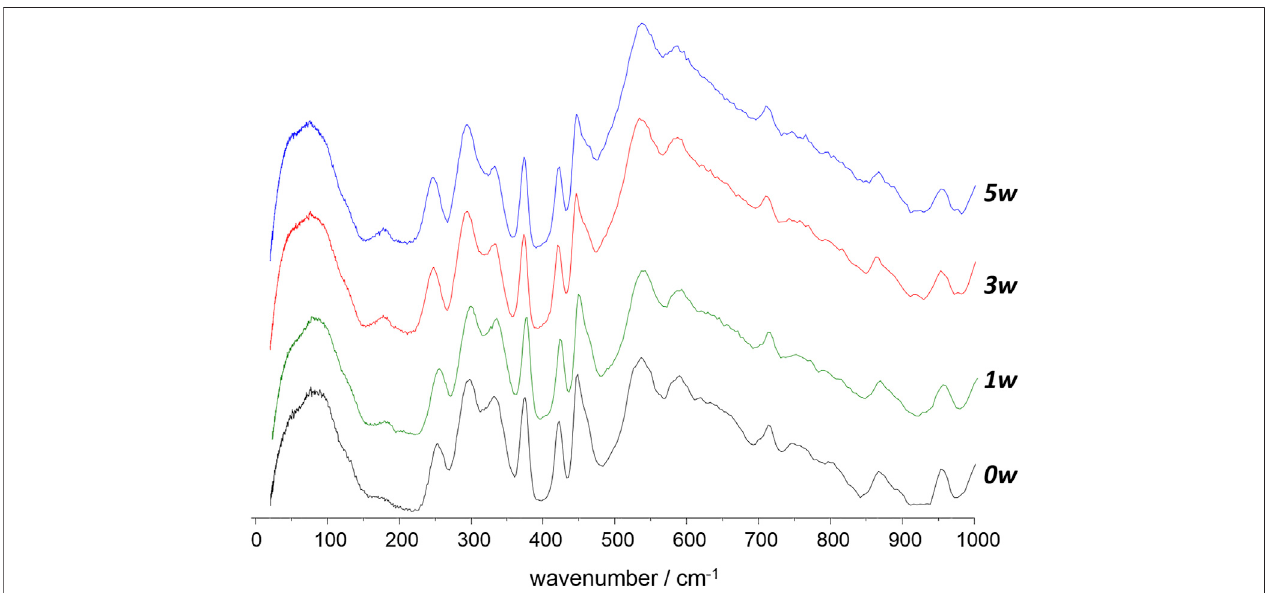
Frontiers in Physics |